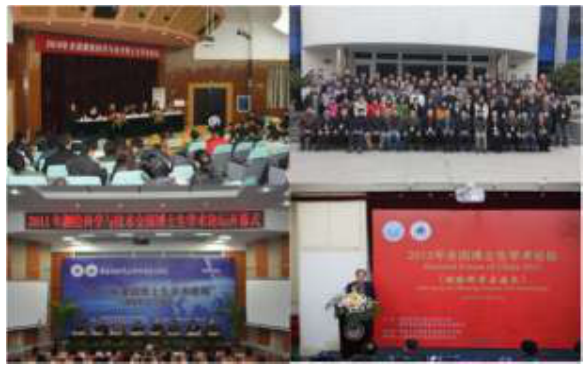
Figure 4. Doctoral forums